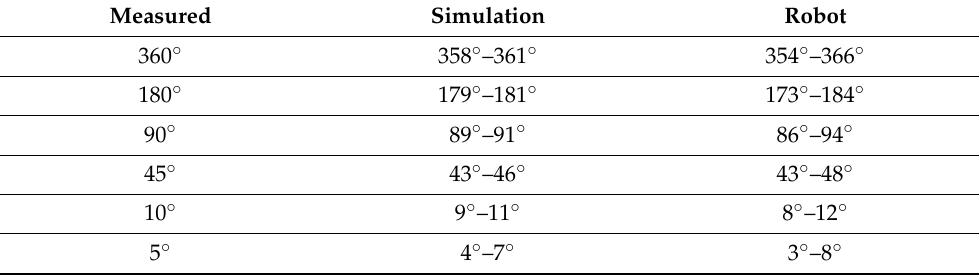
Table 2. Turning parameters.